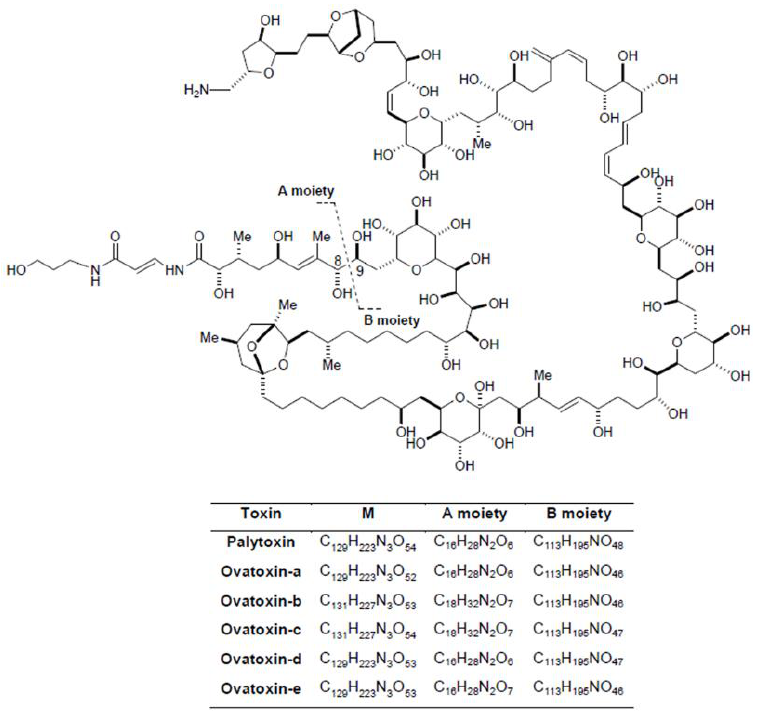
Figure 1. Structure of palytoxins. Molecular formulae (M) of ovatoxins and elemental composition of their relevant A and B moieties.